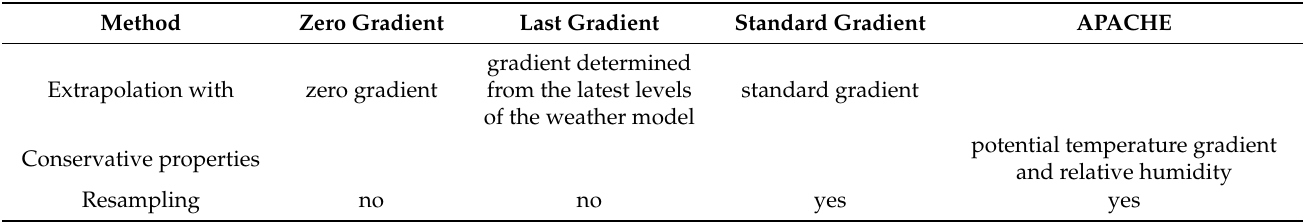
Table 1. Main characteristics of the different vertical interpolation methods.